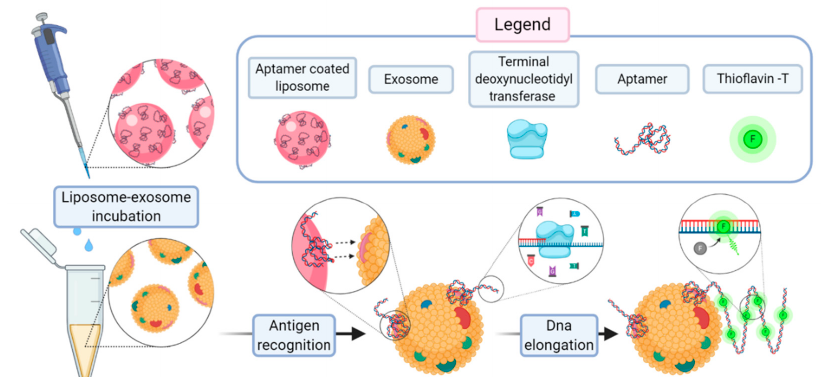
Figure 14. Schematic representation of the key steps of the assay based on the use of aptamer-coated liposomes. The exosome binds through its CD63 moiety (a proteic exosome marker) and the terminal deoxynucleotidyl transferase (TdT) promotes the polymerization with the inclusion of thioflavin T that is the detected reporters. Figure inspired by [73].